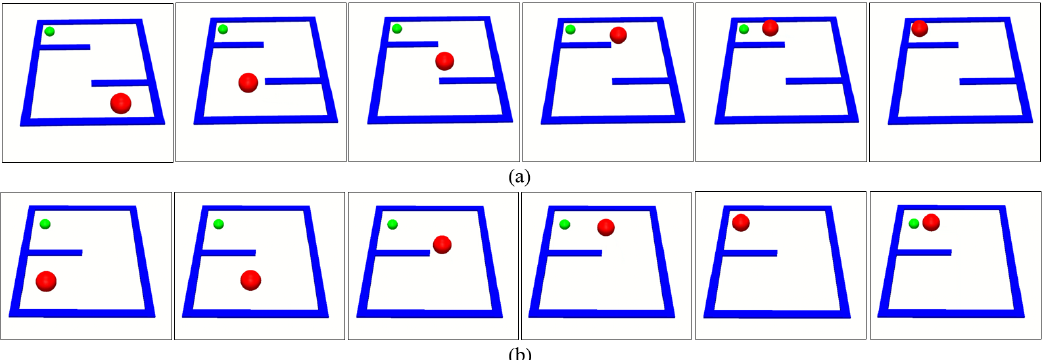
Figure 9. Frames captured from the final policies trained with our proposed method deployed on navigation task in simulated environments. ( a ) two obstacles. ( b ) one obstacle. Best viewed in color.